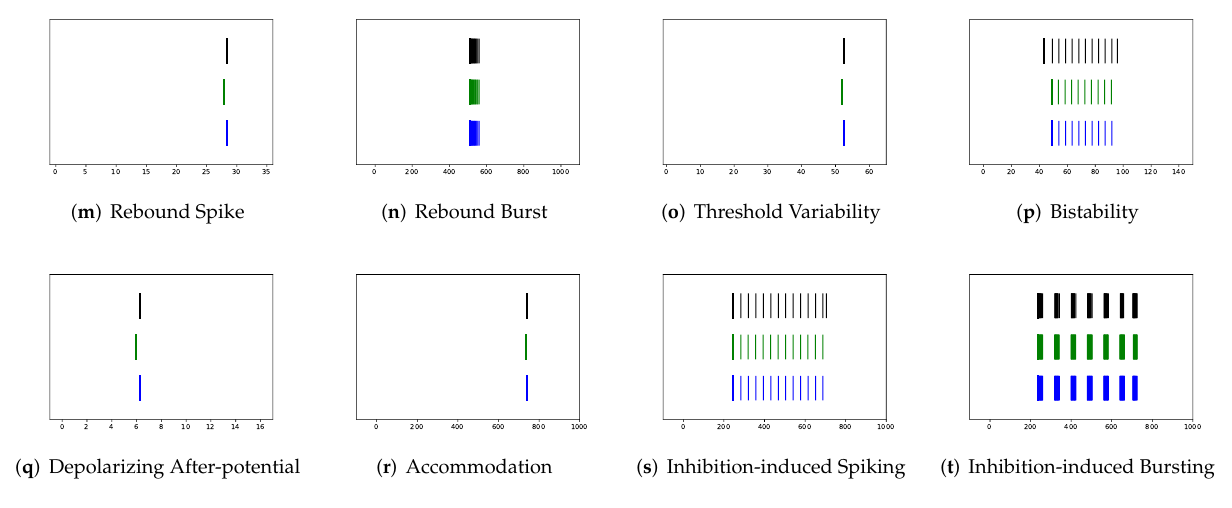
Figure 9. Spike trains of Izhikevich Model (black) vs. unmodified RSSRM (green) vs. modified RSSRM by maximum tolerance (blue), where x-axis is the time (ms).